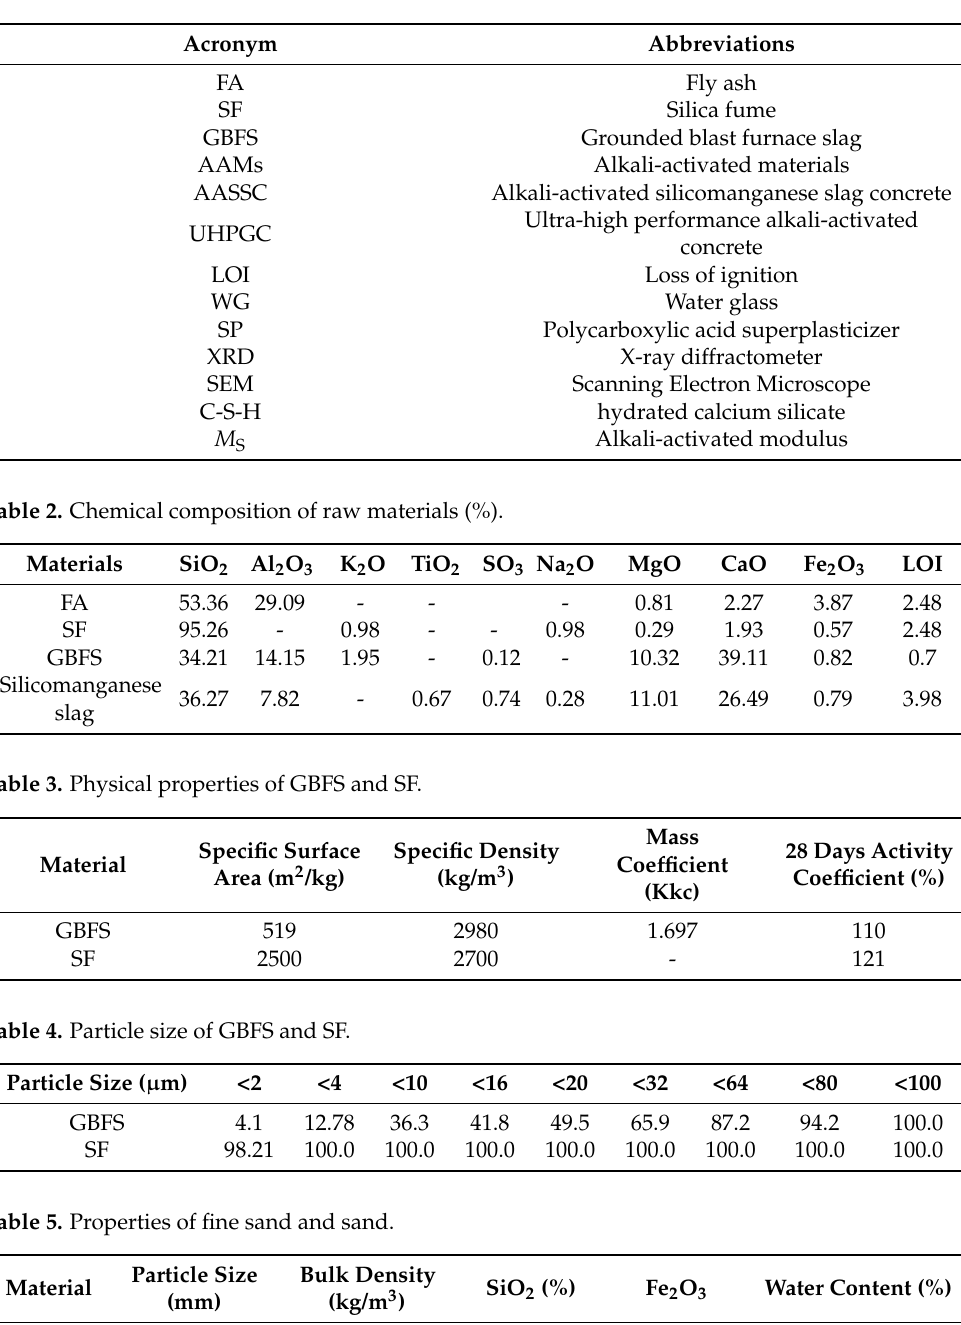
Table 1. List of abbreviations.